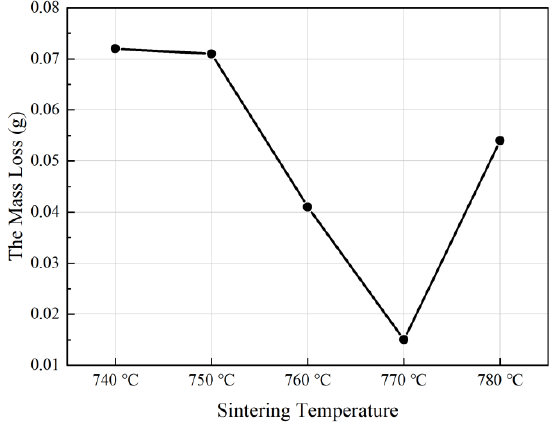
Figure 8. Wear resistance of SD/Cu-Fe sandwich composites.